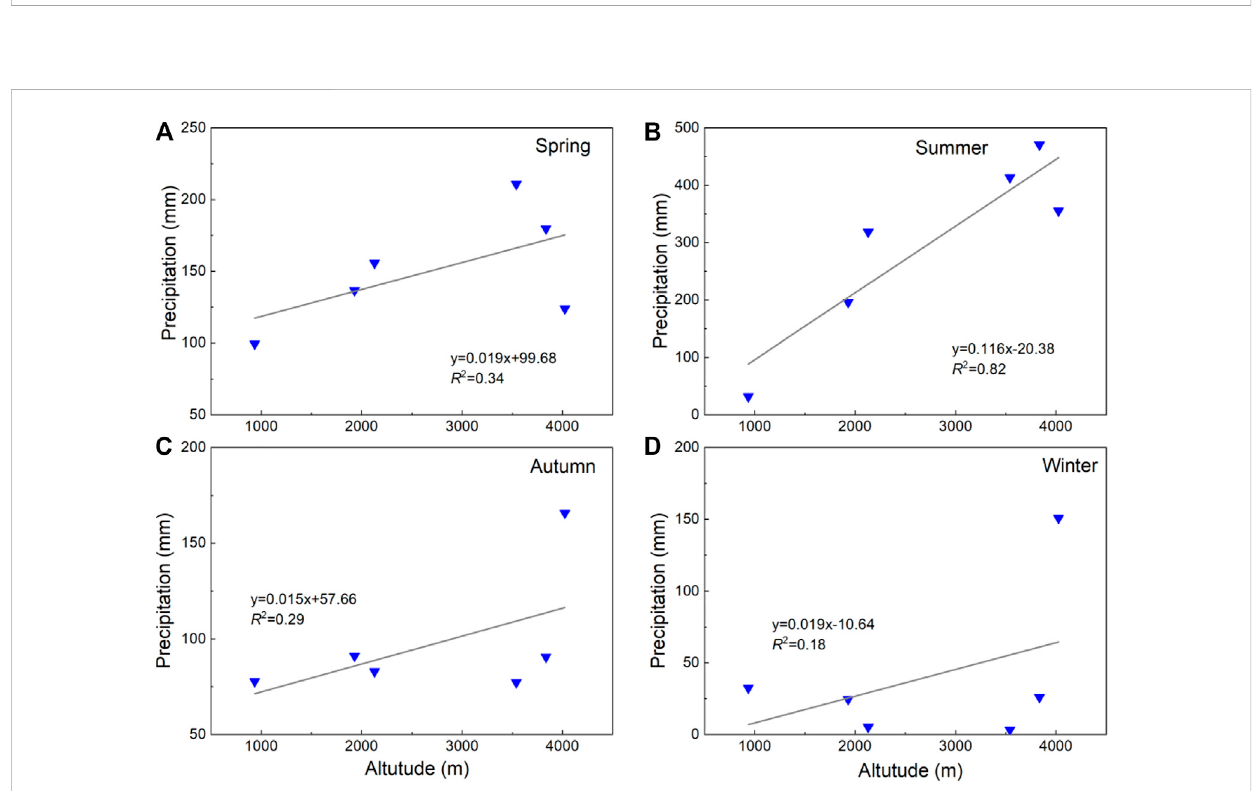
FIGURE 9 Variations of precipitation in Spring (A) , Summer (B) , Autumn (C) and Winter (D) along with elevation in